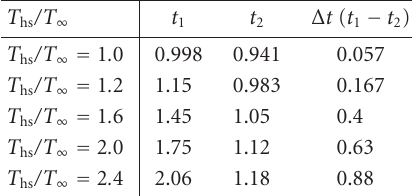
Table 3: Hot streak center temperature and temperature